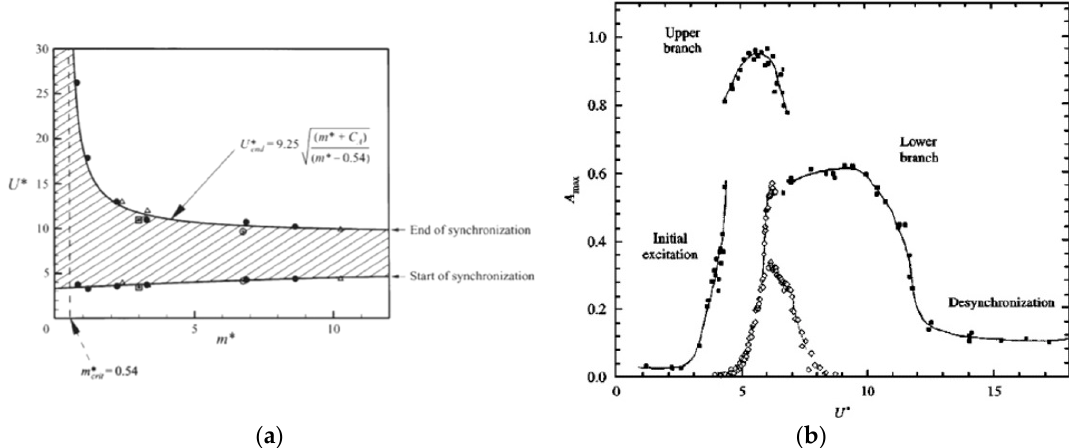
Figure 11. ( a ) Relationship between U r and m* presented by Williamson and Govardhan [23]; ( b ) maximum response amplitudes A max as functions of the reduced velocity U r for m* = 2.4 and m* = 248 [19].